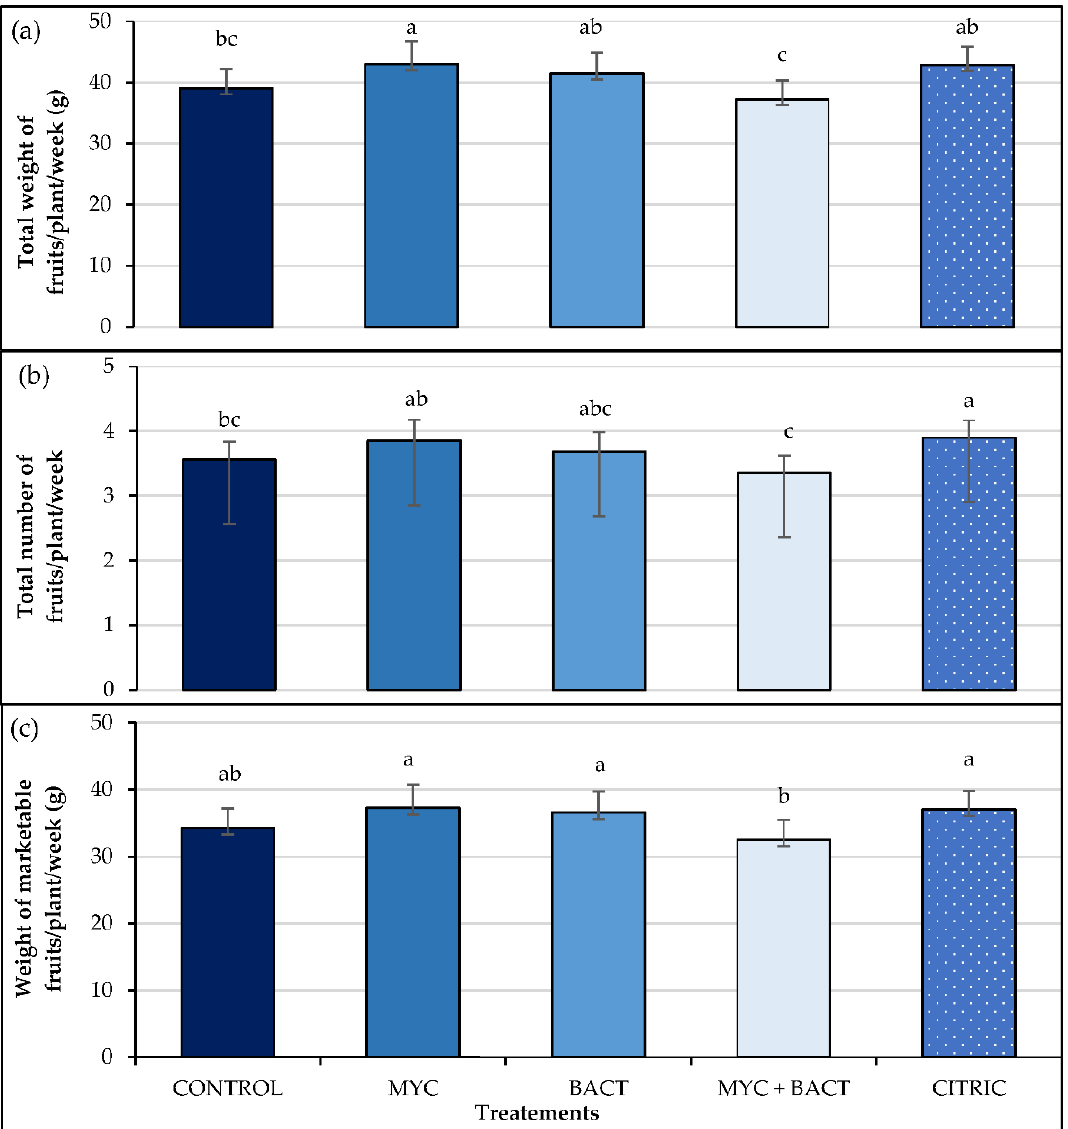
Figure 3. The influence of biostimulants on the total weight of fruits harvested per plant and per week ( a ), total number of fruits harvested per plant and per week ( b ), weight of marketable fruits harvested per plant and per week ( c ) for strawberries grown under high tunnel during summer 2018. Means followed by the same letter are not significantly different ( p ≤ 0.05). CONTROL: without biostimulant; MYC: mycorrhiza ( Rhizoglomus irregulare ); BACT: three bacteria ( Azospirillum brasilense , Gluconacetobacter diazotrophicus , and Bacillus amyloliquefaciens ); MYC + BACT: combination of treatments MYC and BACT; CITRIC: citric acid.